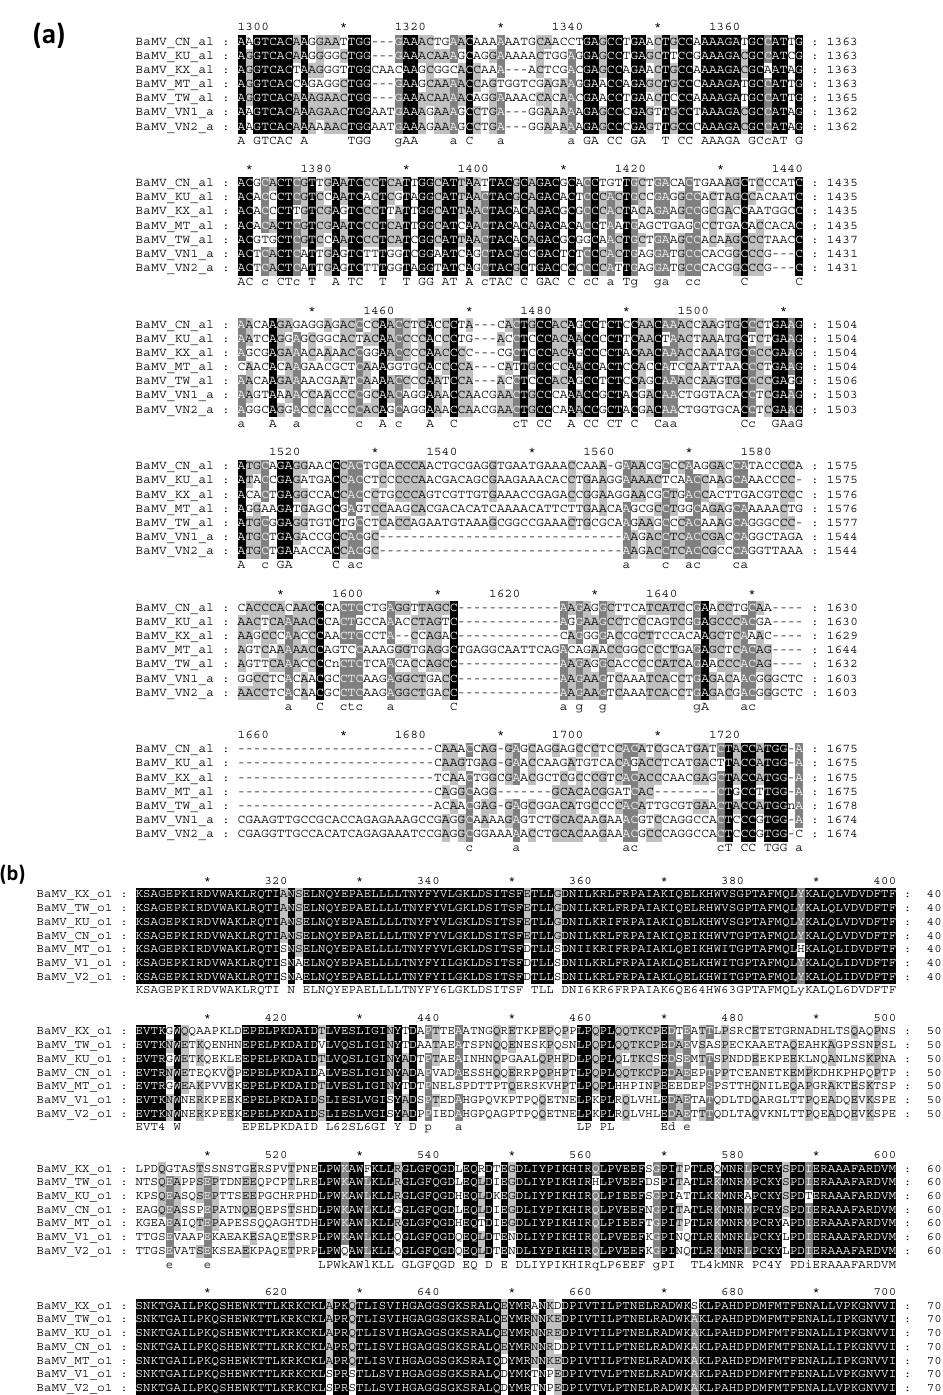
Figure 6. Multiple sequence alignment depicting the highly variable regions in the open reading frame 1 (ORF1) of the Bamboo mosaic virus (BaMV) genome. The consensus sequences of nucleotides ( a ) and amino acids ( b ) of BaMV isolates from different geographical origins were aligned using the software Custal W [31] and illustrated using the software GeneDoc [32]. Identical and consensus residues are shown in black and grey backgrounds, respectively. Deletions were represented by the “-” sign. The names and the relative nucleotide positions are shown on the left and right of each sequence, respectively. The sequence at the bottom of each block represents identical (upper case) and consensus (lower case) residues.